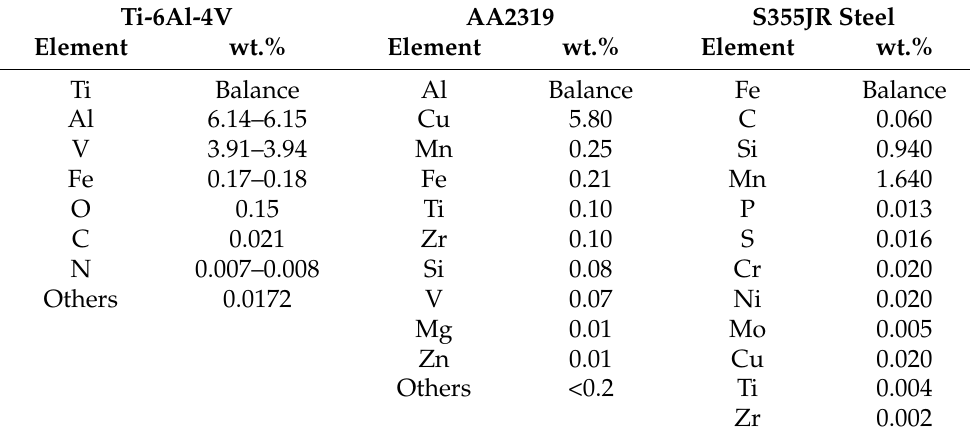
Table 1. Wire composition of Ti-6Al-4V, AA2319 and S355JR